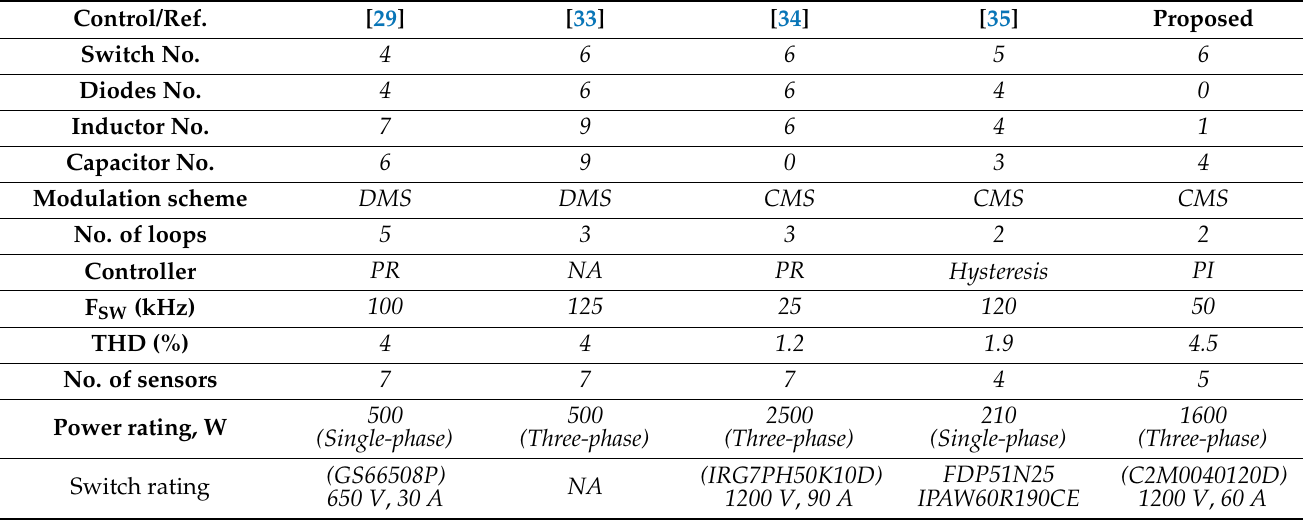
Table 1. Comparison study for MFBDI with its counterpart topologies.